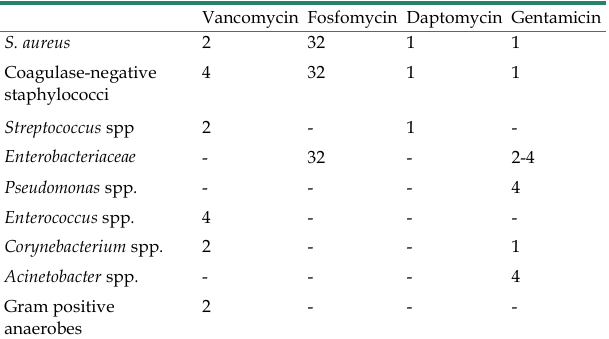
Table 1. Clinical minimum inhibitory concentrations (MIC) in µg/ml (from EUCAST breakpoint tables [17]) Vancomycin Fosfomycin Daptomycin